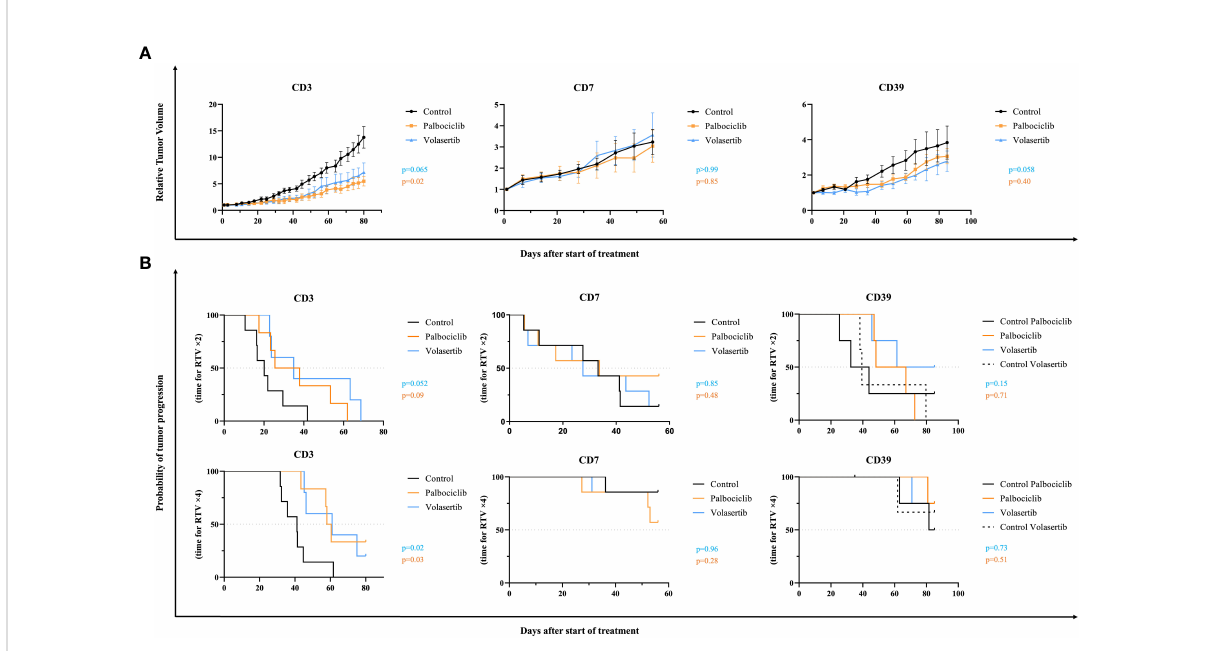
FIGURE 2 In vivo ef fi cacy of palbociclib and volasertib, in the CD3, CD7, and CD39 chordoma PDXs. PDX tumor-bearing mice were randomized into each treatment group (n = 4 – 7 mice per group), and treated with palbociclib 75 mg/kg, 5 days per week (orange), or volasertib 10 mg/kg, 4 days per week (blue). Untreated control is shown in black. (A) Relative tumor volumes. Tumor growth was evaluated by plotting the mean of the relative tumor volume ± SD per group. (B) Probability of tumor progression. The time to reach RTV × 2 and RTV × 4 for each treated mouse has been calculated using Kaplan Meier curves and log-rank